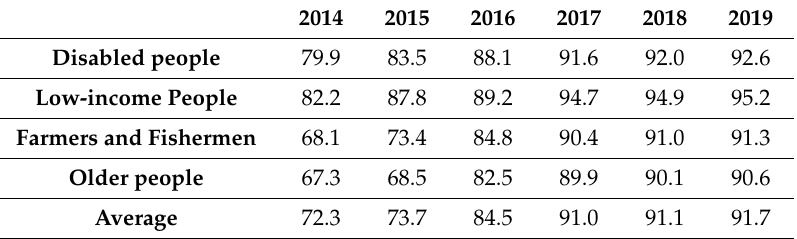
Table 6. Digital Access Level of four groups.